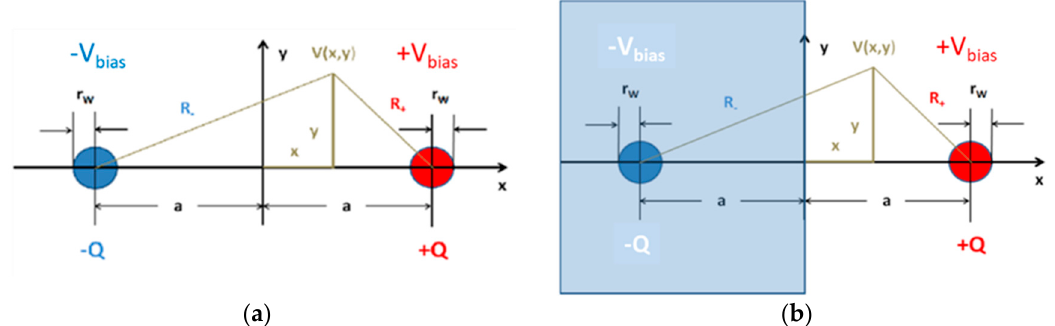
Figure 13. ( a ) Charge and electrical potential distribution in a parallel-nanowire arrangement; ( b ) charge and potential distribution with a positively charged nanowire placed in front of an electrically conducting medium, filling the half-space, x < 0. The negative charge distribution in this case is the image charge induced by the positively charged emitter wire.